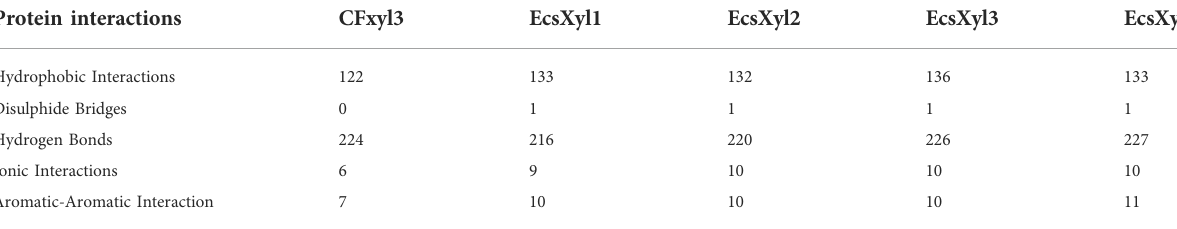
TABLE 2 Comparison of protein interactions of CFxyl3 and four hybrid xylanases. Protein